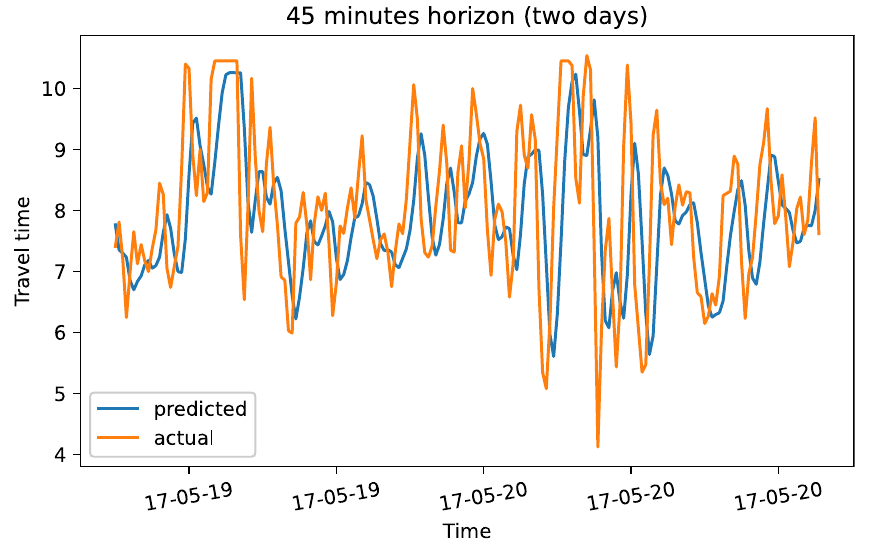
Fig 11. Prediction results for 45 minutes horizon on test data (two days).